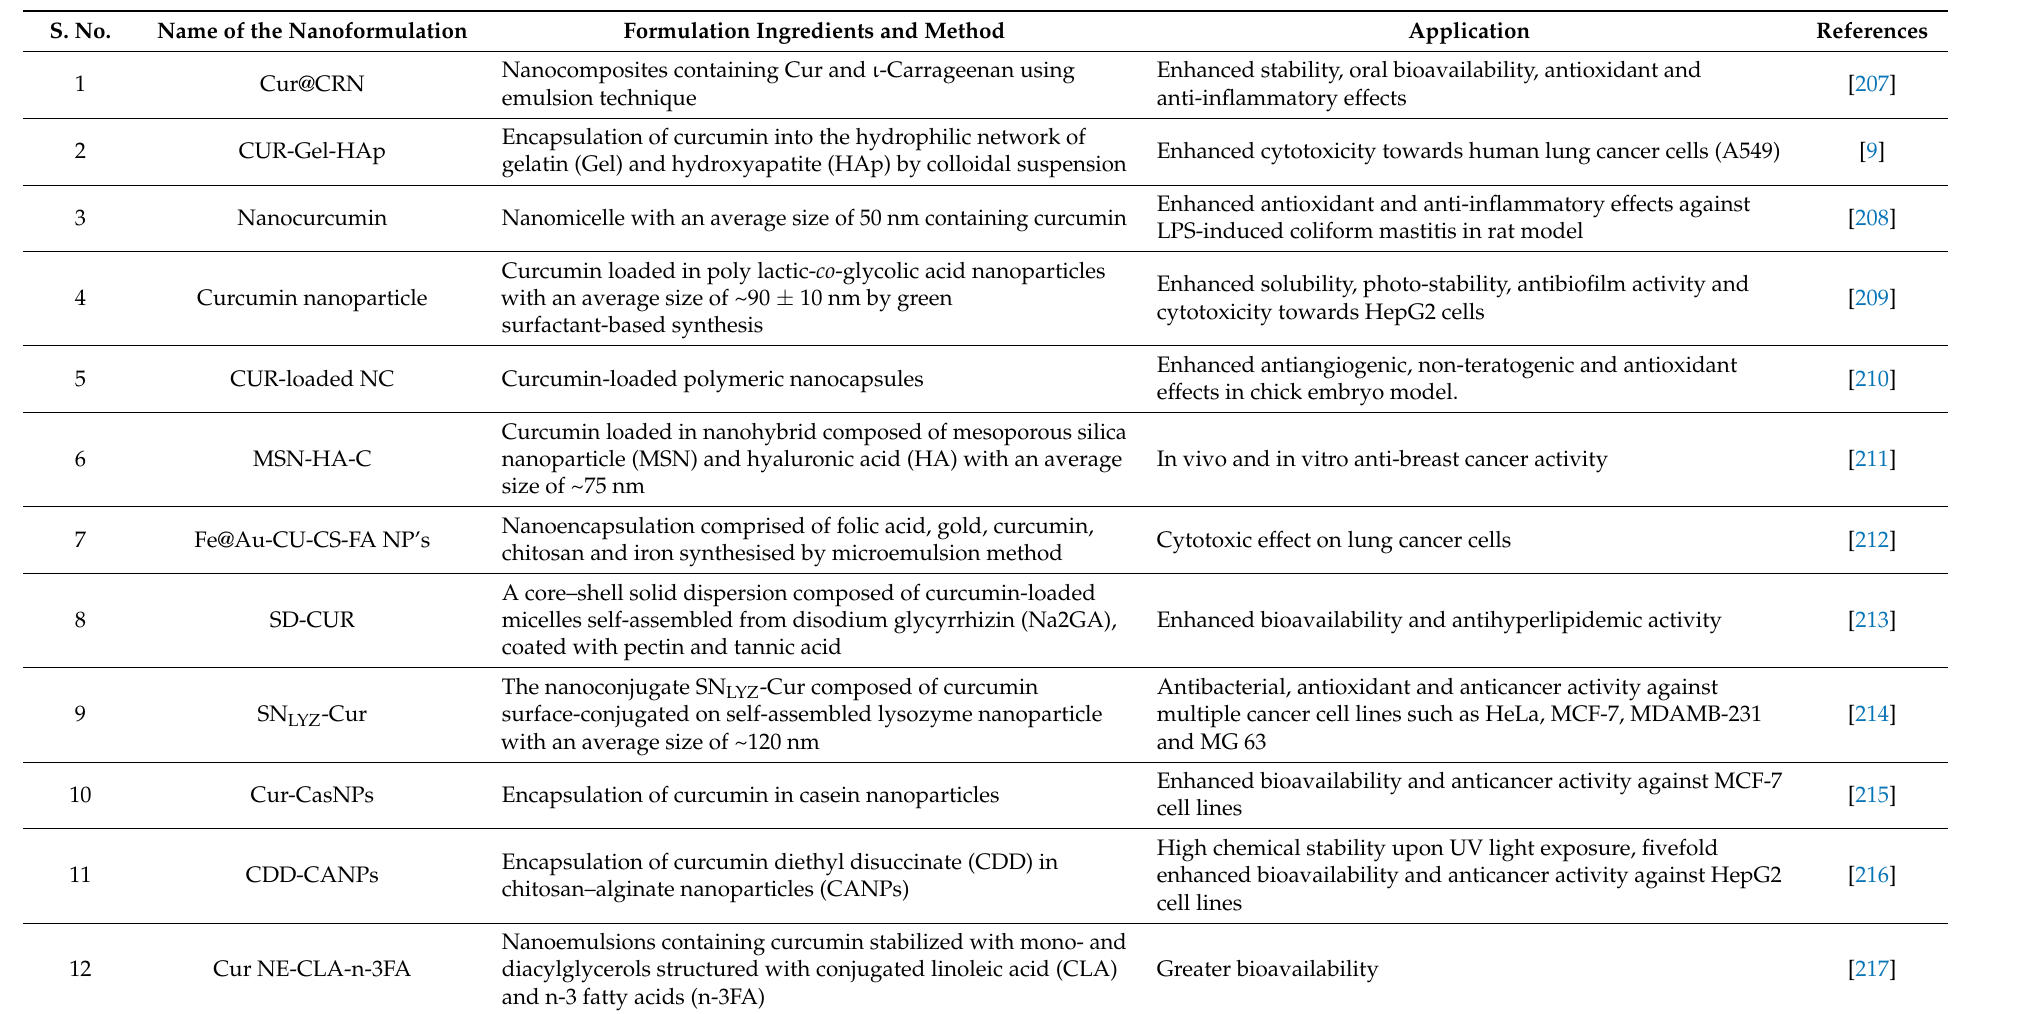
Table 4. Name list of the nanoformulations and their corresponding therapeutic